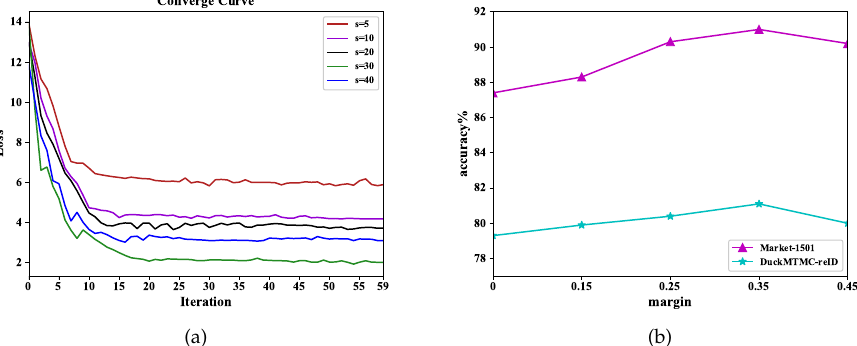
Figure 6. Influence of parameters. Subfigure ( a ) indicates loss convergence with different scaling factors s on Market- 1501. The horizontal and vertical coordinates represent the iteration number and the loss value, respectively. Subfigure ( b ) indicates the accuracy of the MCSL with different margin parameters m on Market-1501 and DukeMTMC-reID. The horizontal and vertical coordinates represent the iteration number and the accuracy,